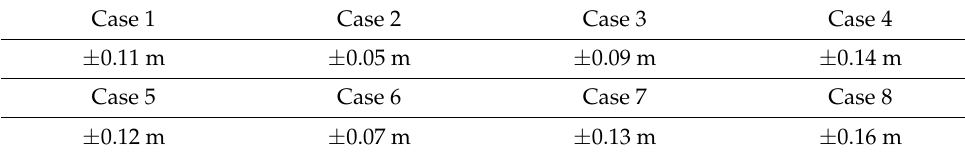
Table 9. The 3D model accuracy